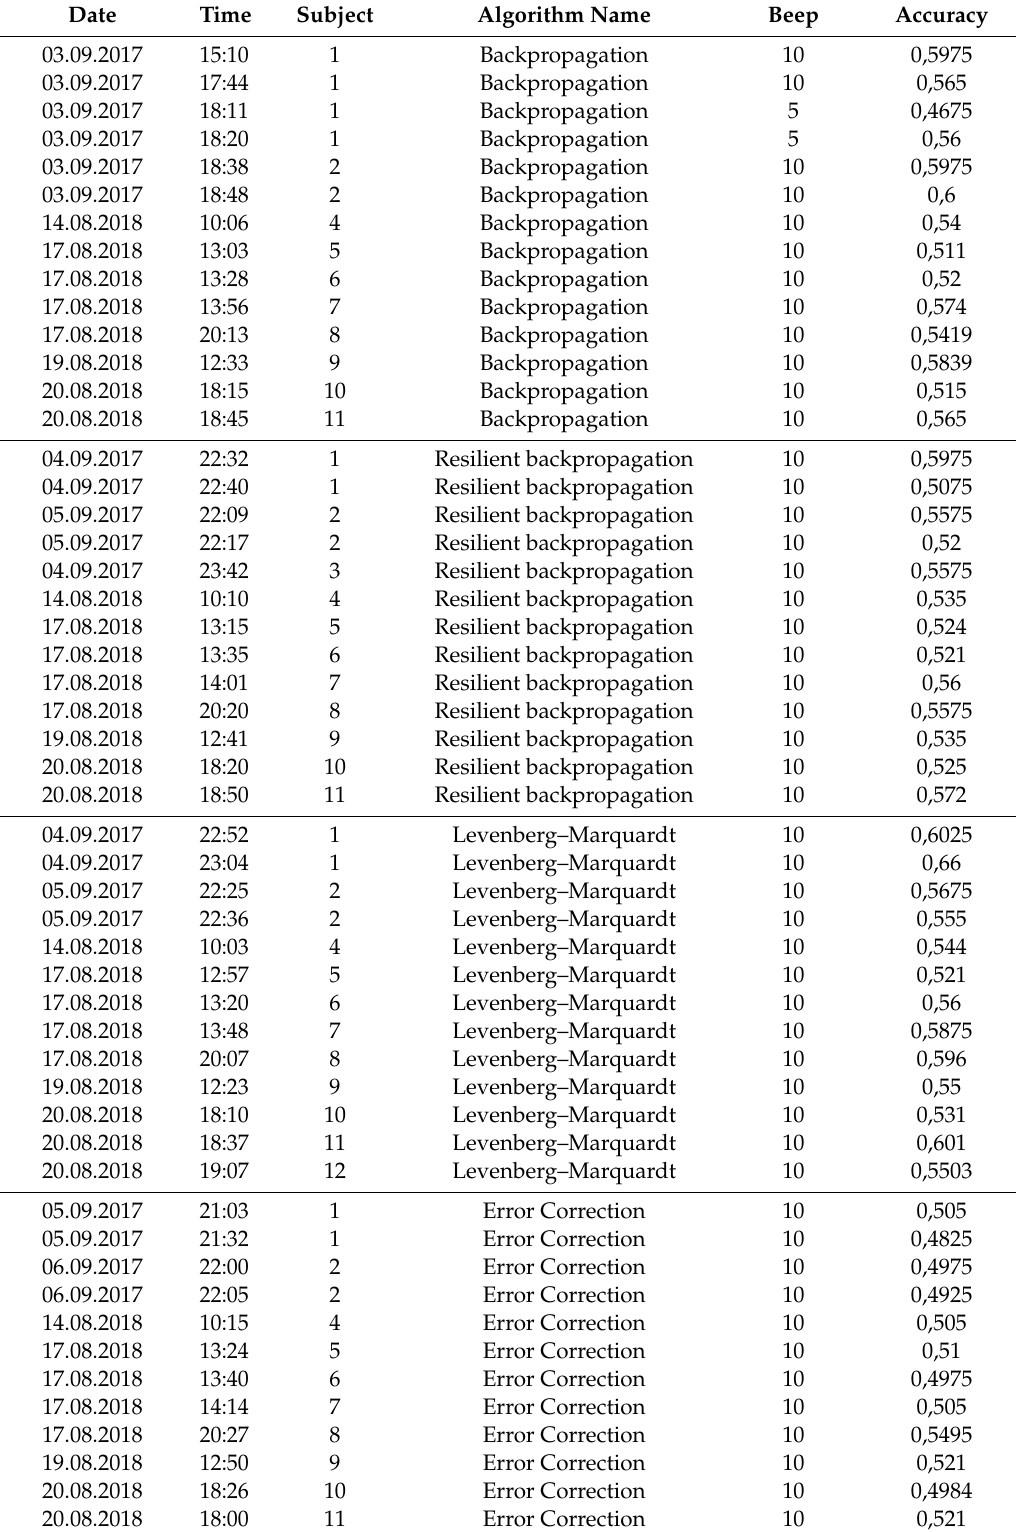
Table 3. Results of the second